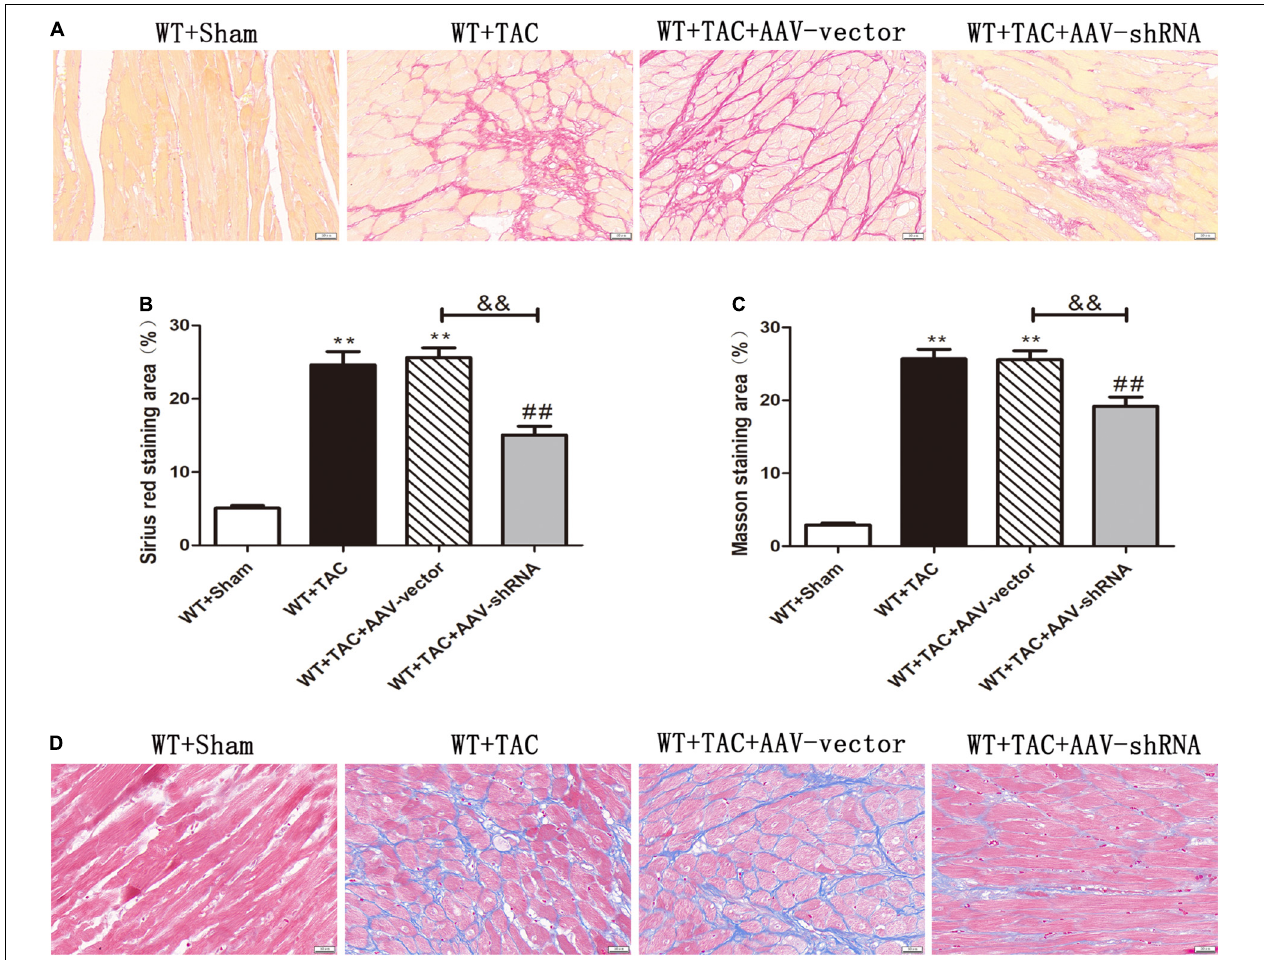
FIGURE 11 | Interference with RIPK3 can improve the degree of collagen deposition and myocardial fibrosis in HF mice. Male 8-week-old WT mice were pretreated with AAV-vector and AAV-shRNA through the tail vein, and TAC was performed using a 28-g needle. The control group received sham surgery. All groups of mice were given continuous feeding for 6 weeks. Hearts were then obtained for correlative testing. (A) Sirius red staining, bar = 50 µ m. (B) Sirius red staining area measurements. (C) Masson staining area measurements. (D) Masson staining, bar = 50 µ m. Compared with WT + sham group, ** P < 0.01; compared with WT + TAC group, ## P < 0.01; compared with WT + AAV-vector group, && P < 0.01. n =